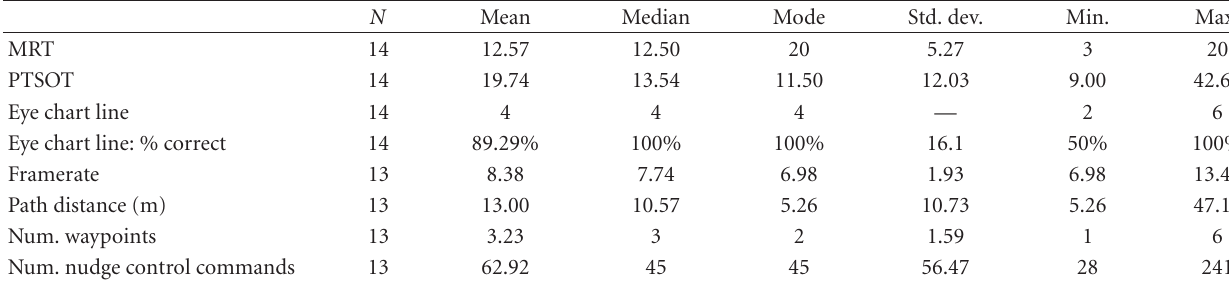
Table 1: Performance descriptive statistics.